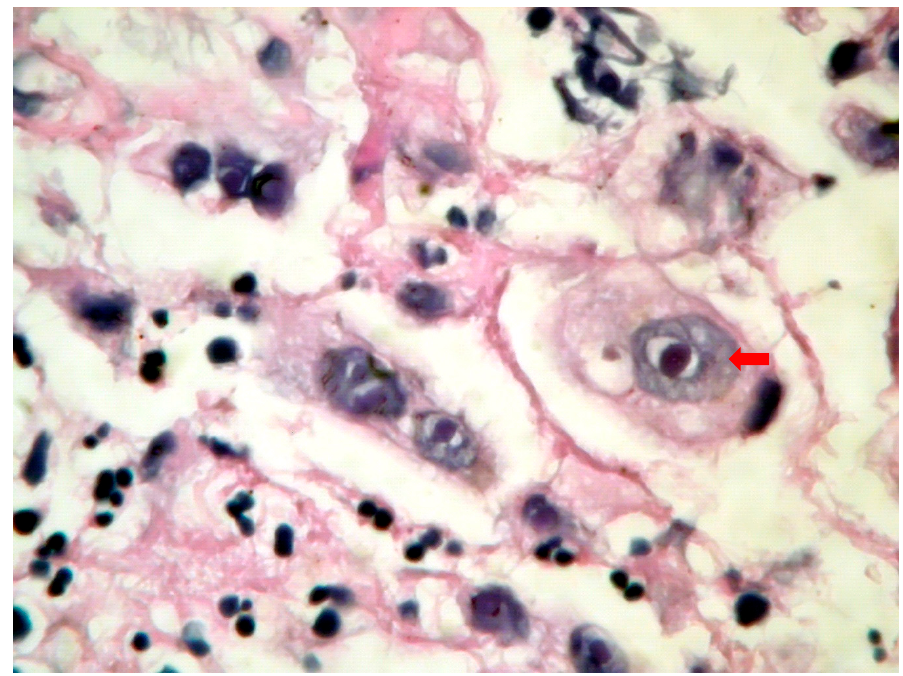
Figure 2. Cytomegalovirus (CMV)-induced esophagitis (microscopy-HE, 1000×):intracytoplasmic and intranuclear large, basophilic inclusion bodies surrounded by a clear halo (Cowdry type